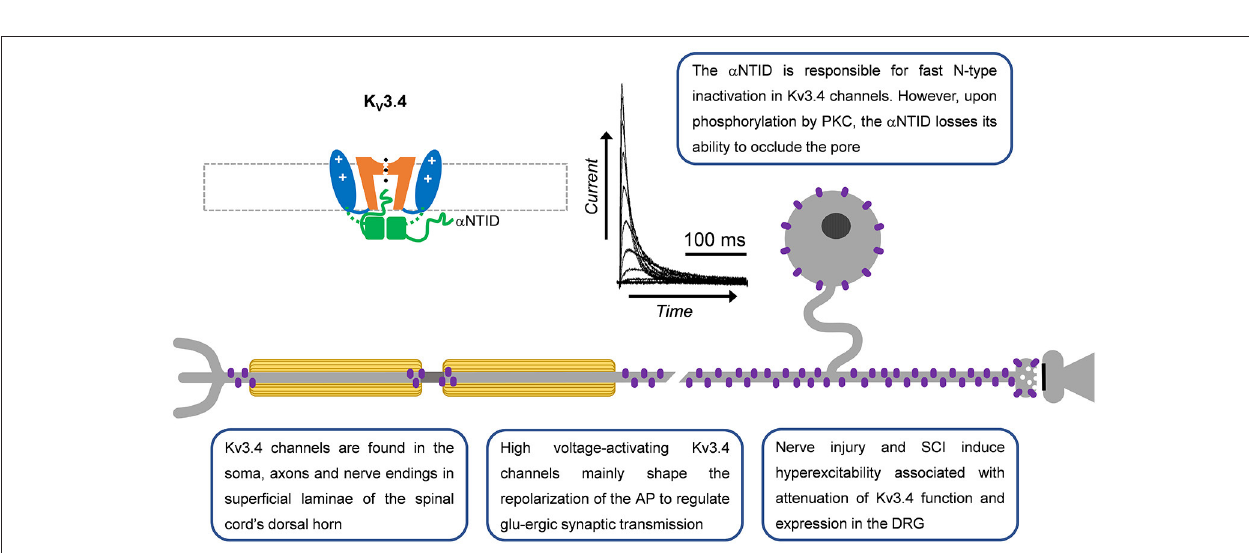
FIGURE 3 | A-type Kv3.4 channels in primary nociceptive neurons. Cartoon rendering of the Kv3.4 channel displaying major functional domains of the pore-forming α -subunit ( Figure 2 ; VSD, PD, T1, and α NTID). The α NTID occludes the open pore to induce a fast inactivating current profile. Kv3.4 immunoreactivity has been detected in somata, axons and nerve endings. In the latter location, attenuation of Kv3.4 function would prolong the AP and, thereby, potentiate glutamatergic (glu-ergic) synaptic transmission, ultimately resulting in increased